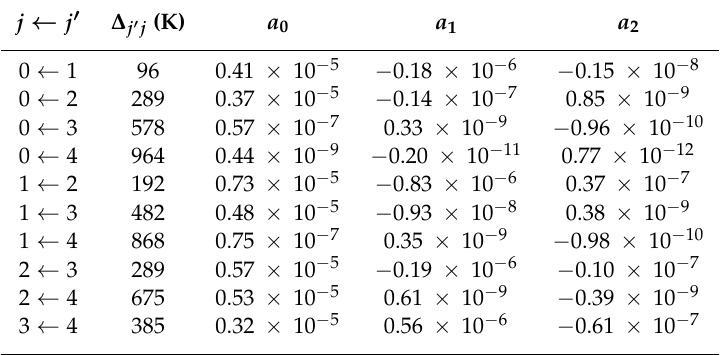
( x ) of Equations (4) and (5) for several pairs jj (cid:48) ( x ) multiplying them with jj (cid:48)